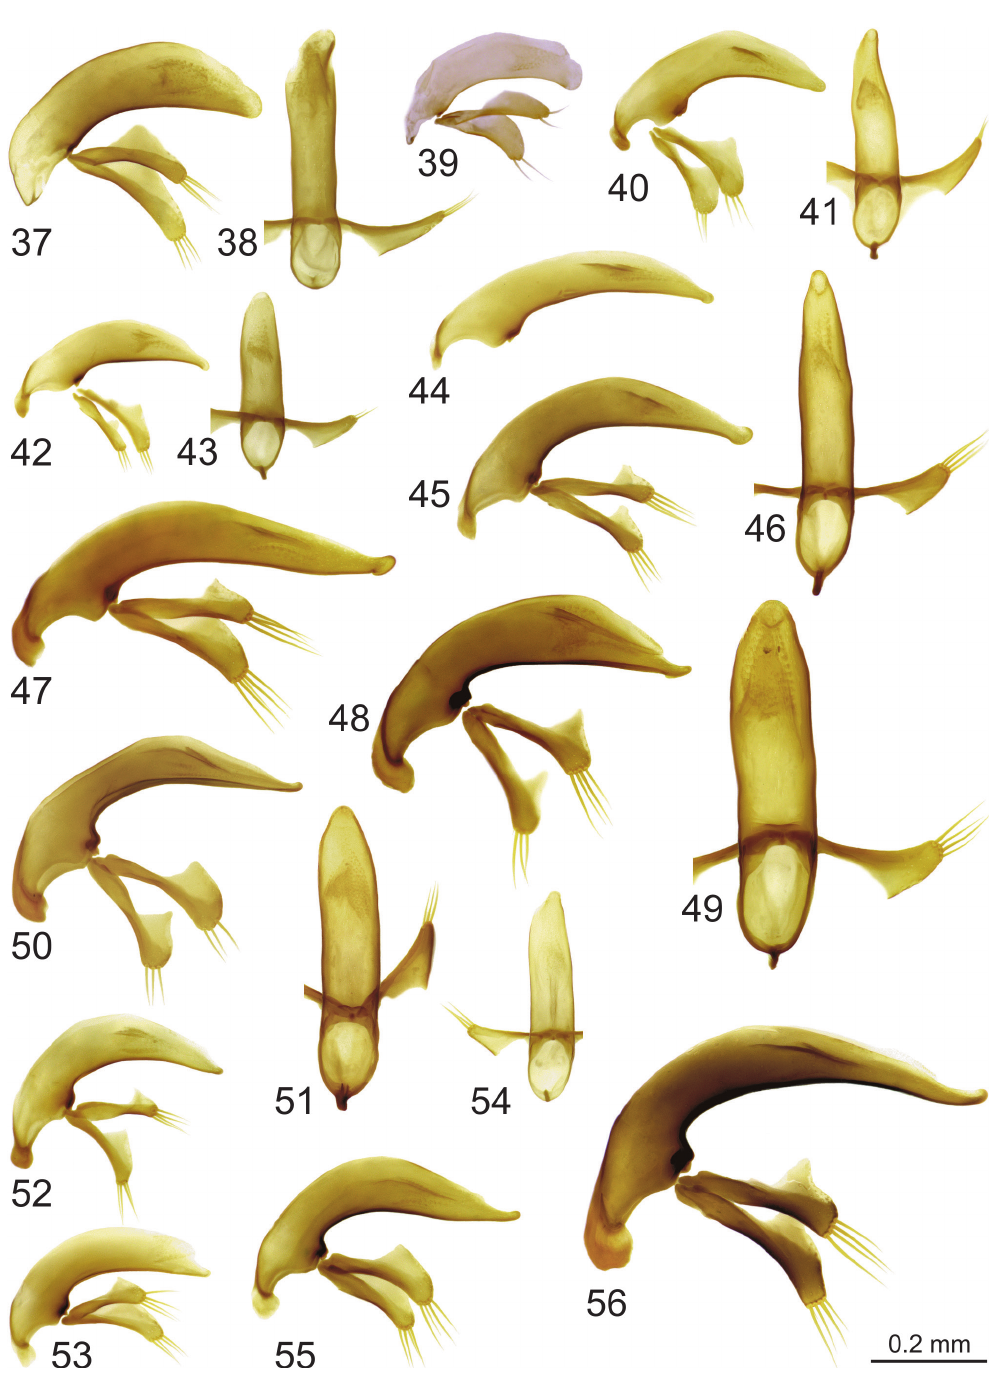
Figs 37–56. Trechus spp., aedeagal median lobe, left lateral view (37, 39, 40, 42, 44–45, 47–48, 50, 52–53, 55–56) and dorsal view (38, 41, 43, 46, 49, 51, 54). 37–38 . T. mattisi sp. nov.,